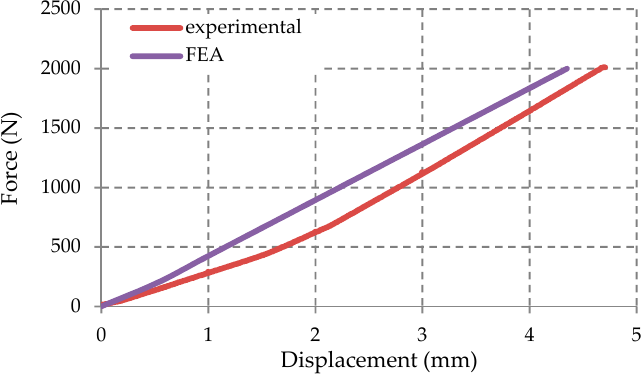
Figure 22. Comparison of the force-displacement curve: Experimental versus FEA.